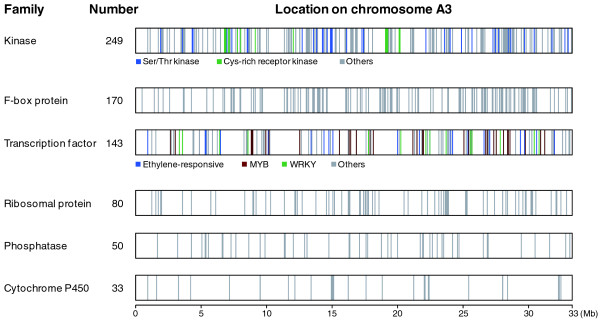
Distribution patterns of the top six gene categories on chromosome A3. Width of the vertical bars is proportional to the number of genes located at that position.